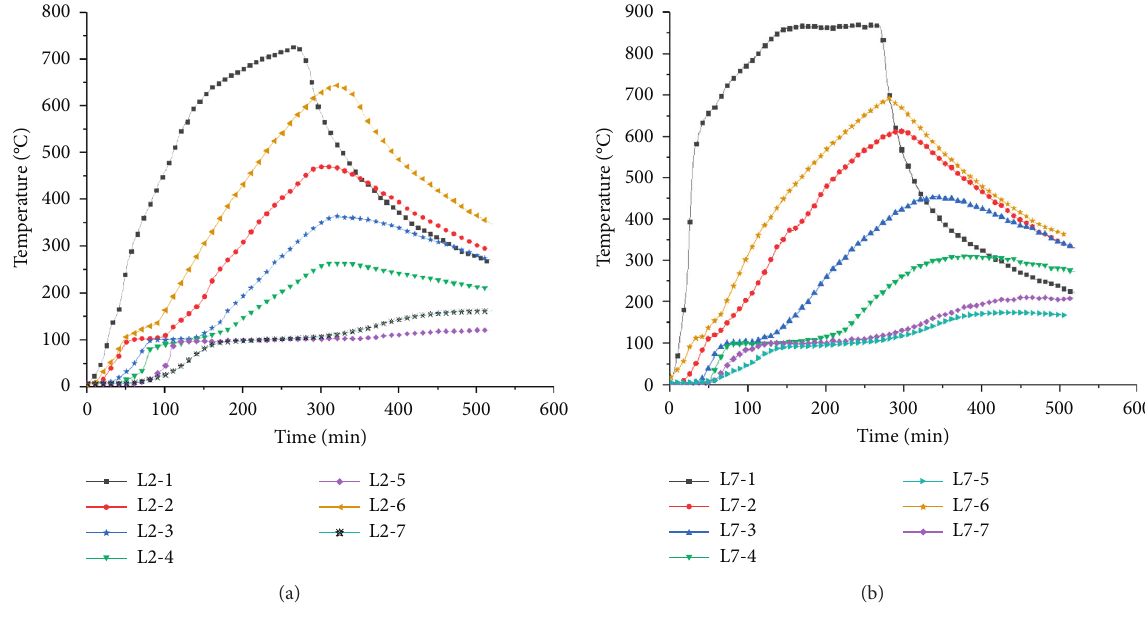
Figure 13: Temperature-time relationships of ribbed girders. (a) L2 measure point; (b) L7 measure